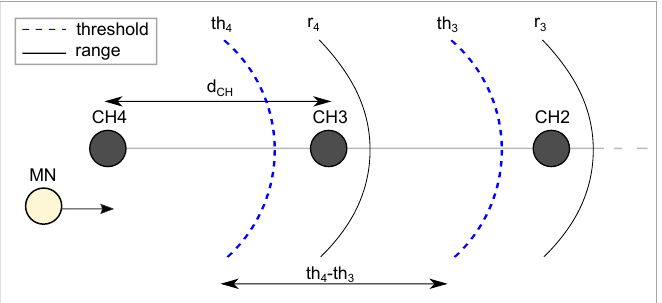
Figure 4. Node speed